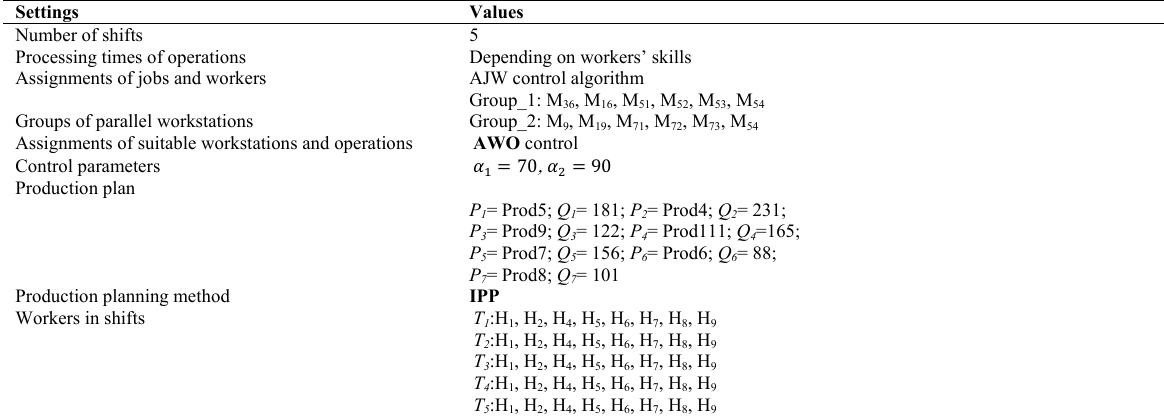
Settings of the test environment for adjusting 𝛽 parameters Settings Values Number of